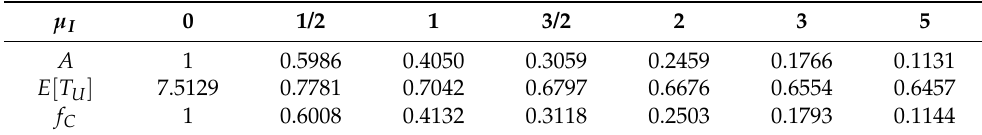
Table 2. Some performance measures for different values of inspection mean time.